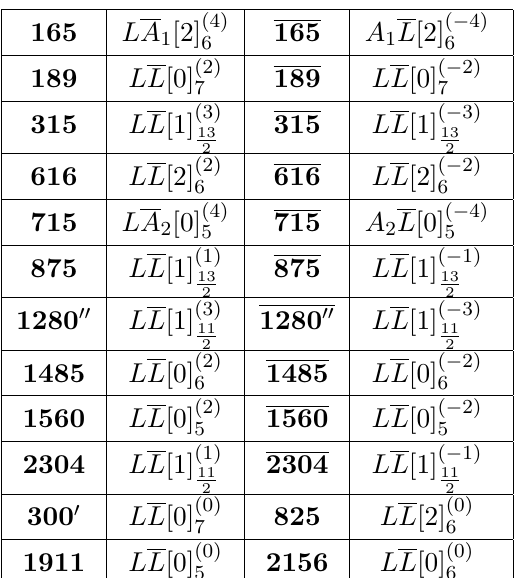
Table 13 . The N = 2 multiplets from level n = 6 .